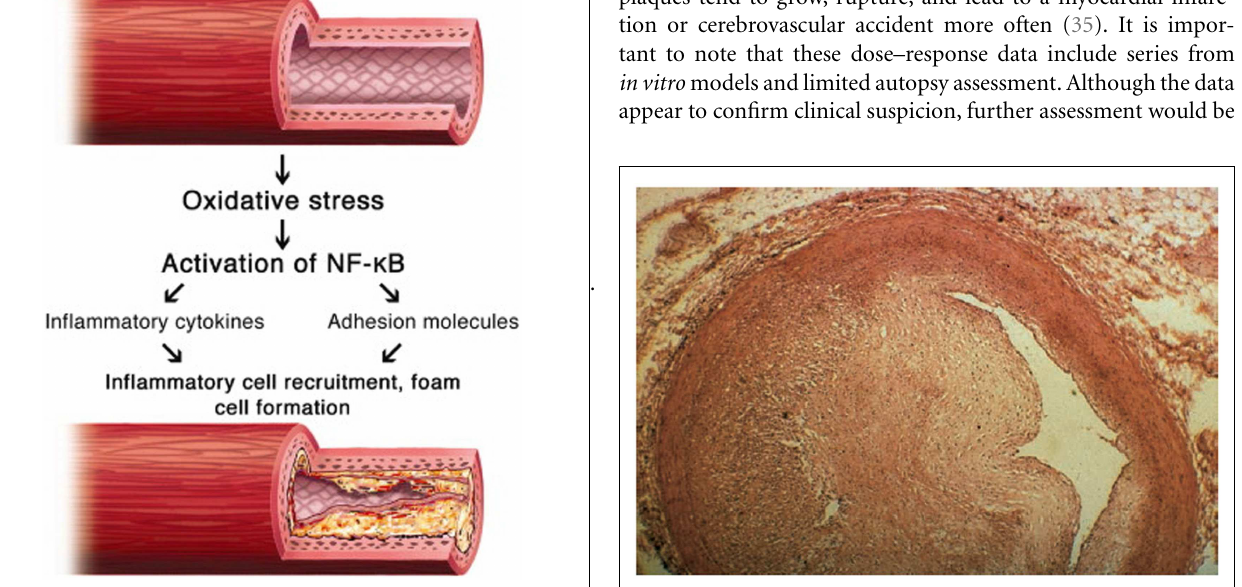
FIGURE 2 | Proposed mechanism of involvement of NF- κ B in radiation-induced vascular disease (28)